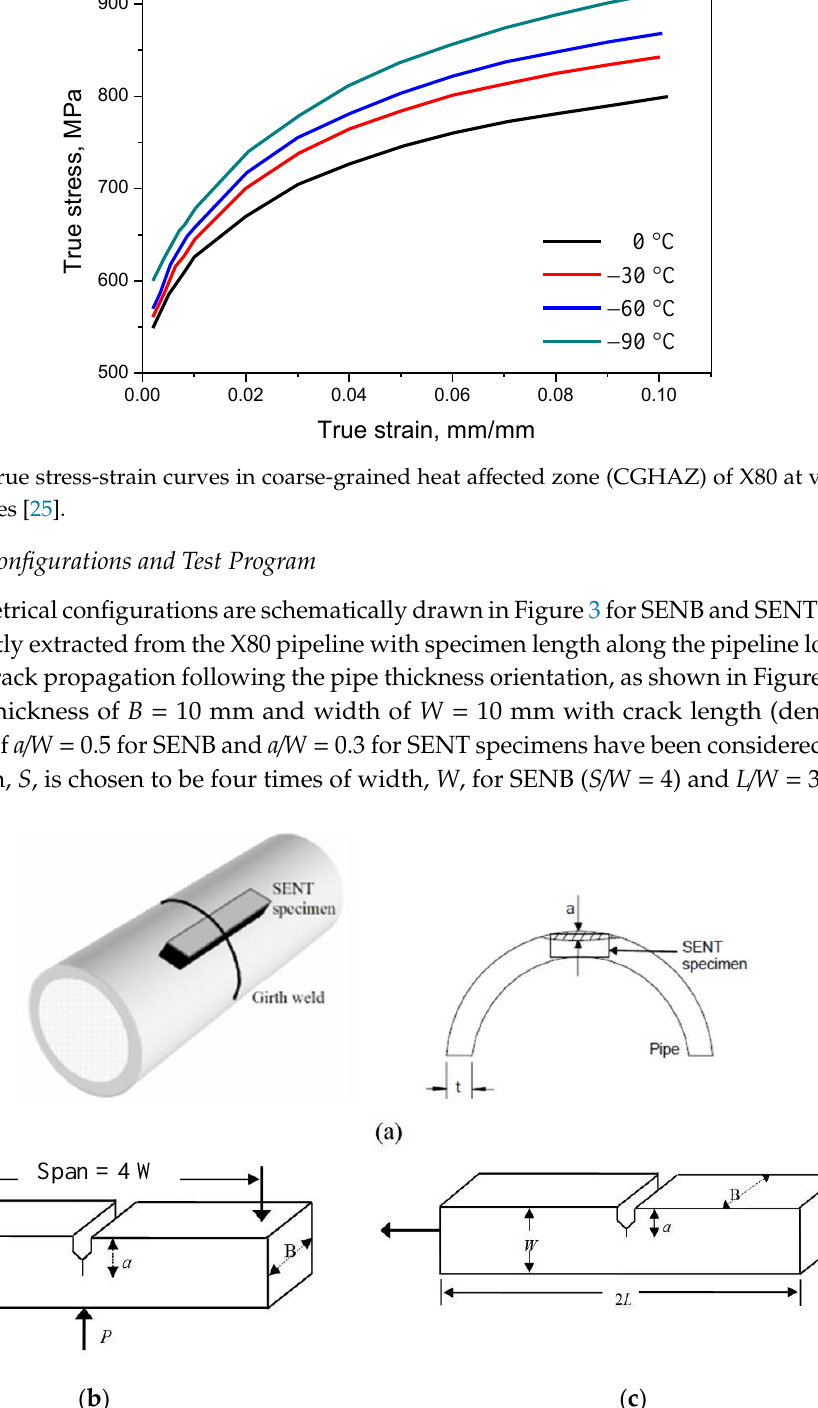
Figure 2. True stress-strain curves in coarse-grained heat affected zone (CGHAZ) of X80 at various temperatures [25].